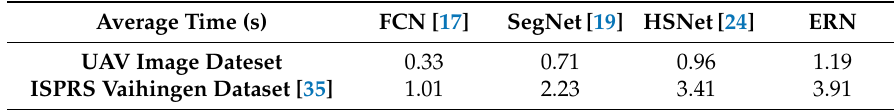
Table 8. Average semantic segmentation time per image in the